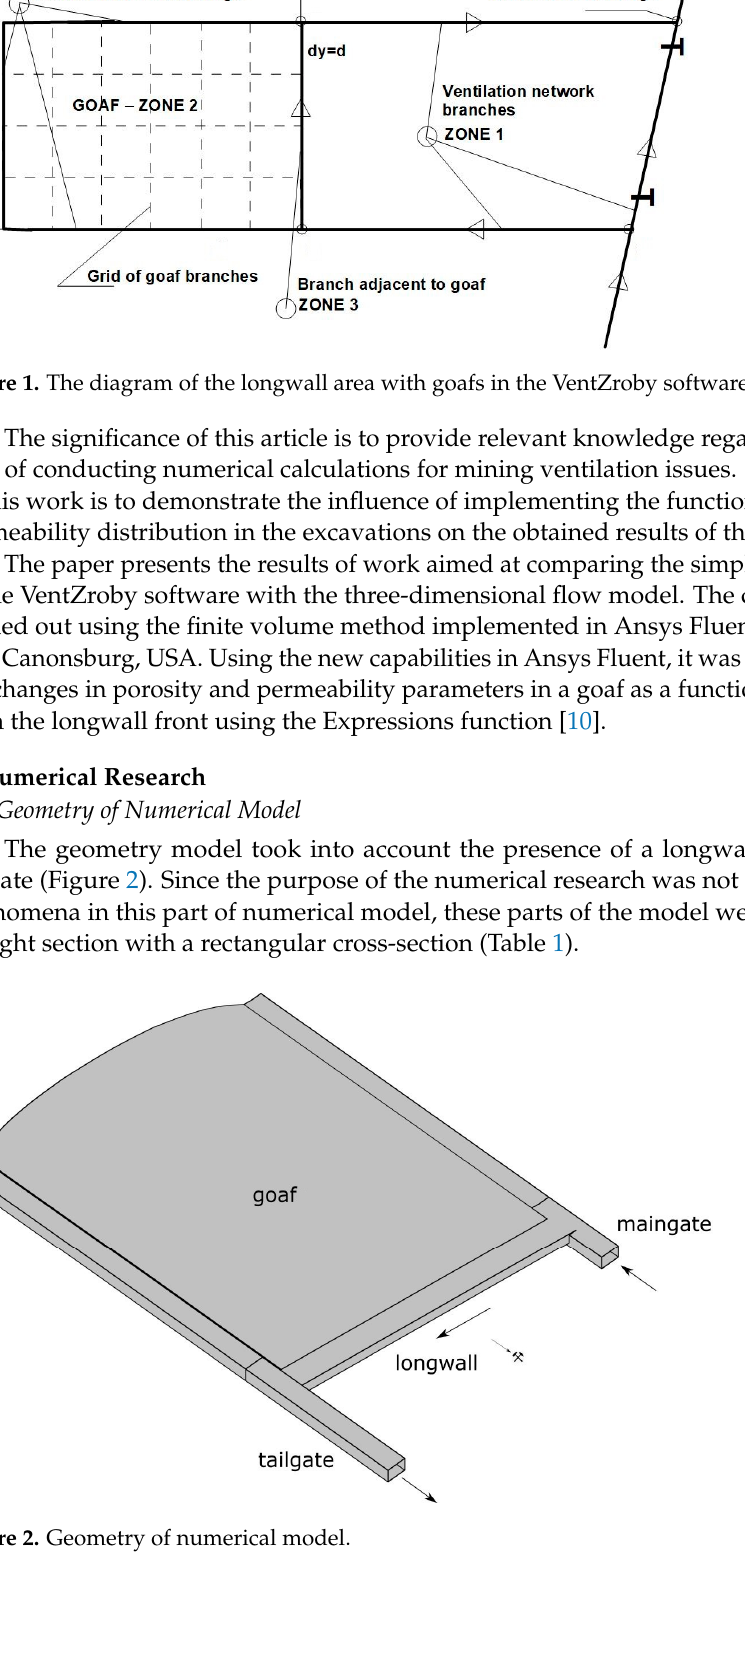
Figure 3. Goaf height distribution—perspective view. 2.2. Computational Grid The authors decided to use mesh with different sizes of cells due to the areas with laminar flow (goaf) and turbulent flow (mine drifts). The entire process of imposing a computational grid using the size function was widely described in [10]. In the area with turbulent flow, the size of the 4 mesh was from 7.0 cm to 20 cm, with a growth rate of 1.2. On the other hand, in the area with laminar flow, the size of the mesh was from 50.0 cm to 200 cm, with a growth rate of 1.2. In the first step, the non-structural tetrahedral mesh was applied. In turn, this was converted in the Ansys Fluent software into a polyhedral mesh consisting of approximately 5 million cells (Figure 4).